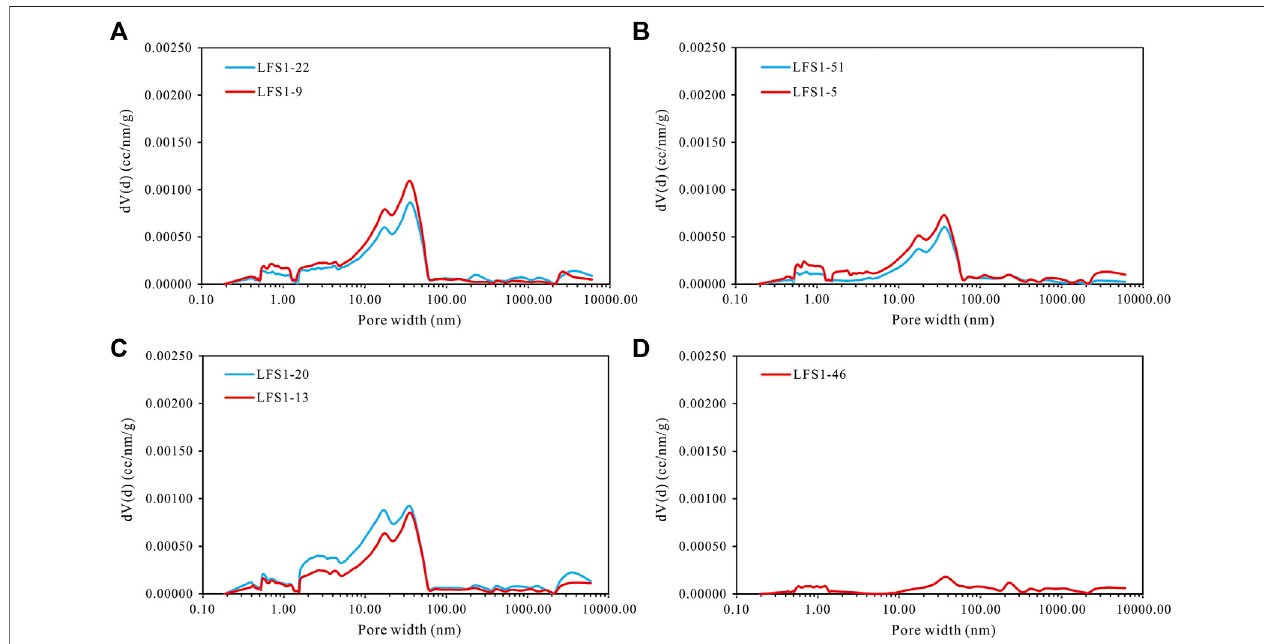
FIGURE 6 | PSD of four types of lithofacies for shale samples in the Shahezi Formation. (A) ORS shale; (B) ORM shale; (C) ORA shale; and (D) ORC shale. Note: 0 – 2 nm, CO 2 DFT model; 2 – 50 nm, N 2 BJH model; > 50 nm, mercury intrusion.